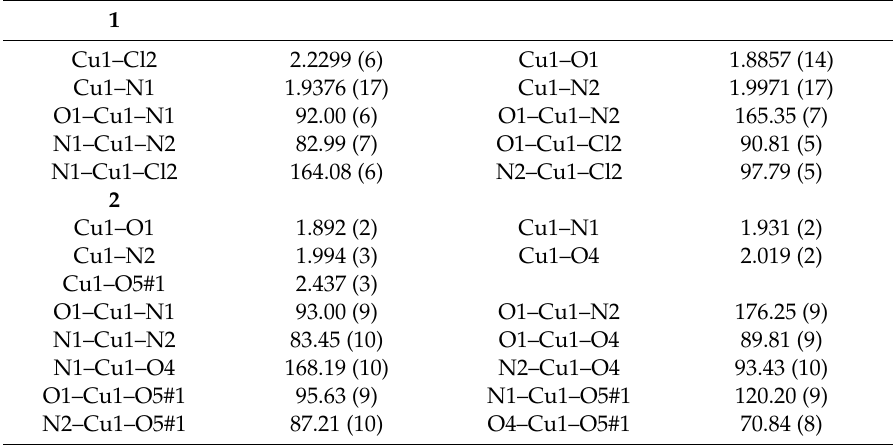
Table 2. Selected bond lengths (Å) and angles ( ◦ ) in 1 and 2 a .